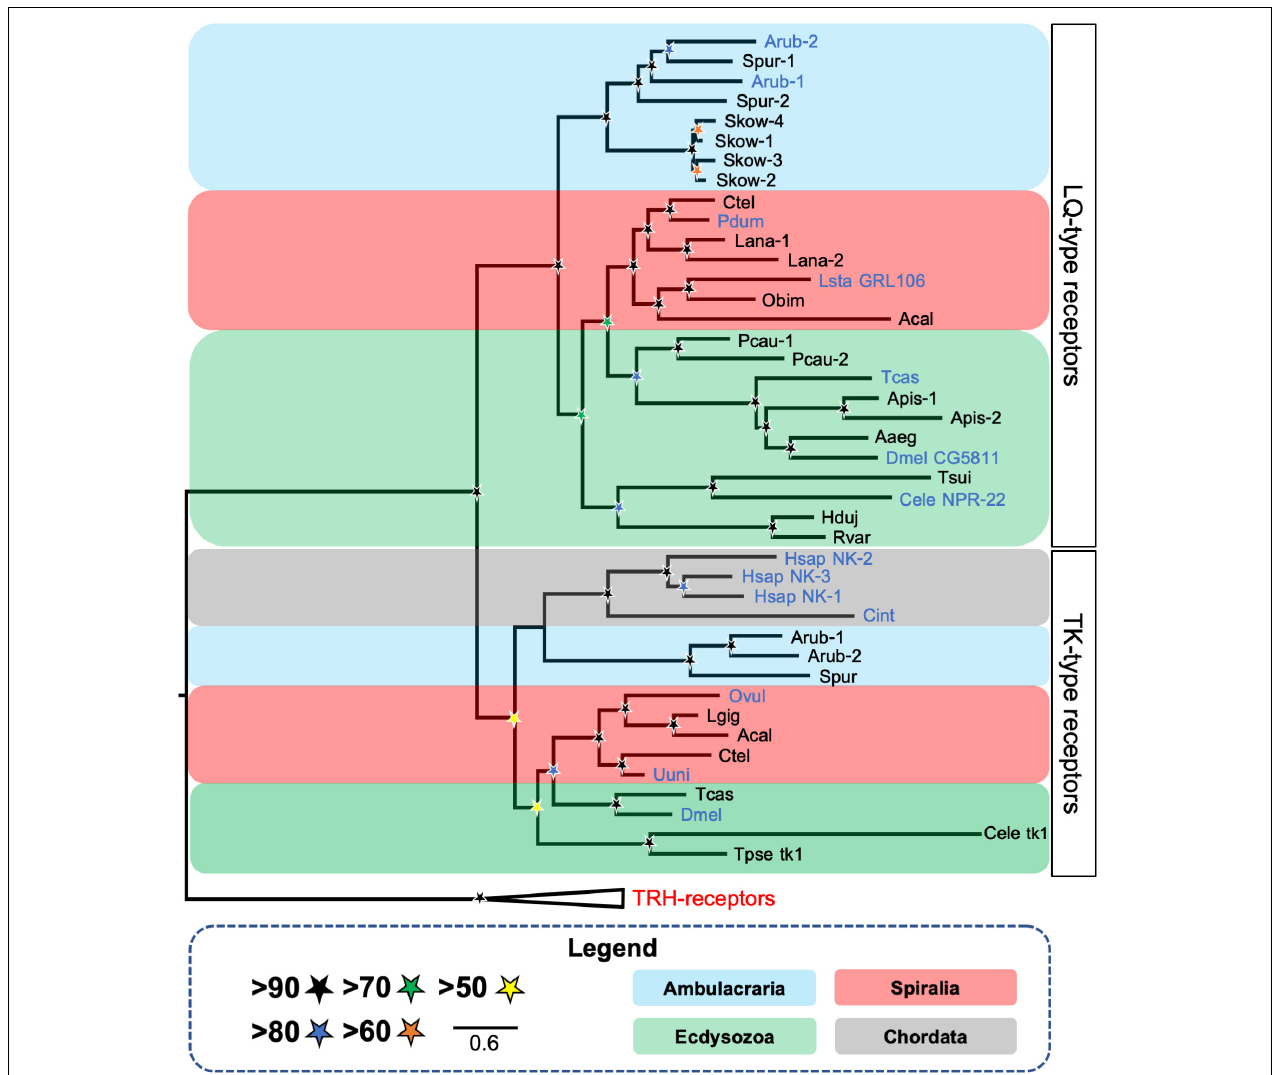
FIGURE 2 | Phylogenetic tree showing the occurrence and relationships of luqin/RYamide-type receptors and tachykinin-type receptors in bilaterians. The tree comprises two distinct receptor clades—luqin/RYamide-type receptors and the paralogous tachykinin-type receptors, with thyrotropin-releasing hormone (TRH)-type receptors included as an outgroup. Taxa are color-coded and SH-aLRT support (Guindon et al., 2010) [1000 replicates] for clades is represented with colored stars, as explained in the key. Species in which the peptide ligands that activate luqin/RYamide-type receptors or tachykinin-type receptors have been identified experimentally are shown with blue lettering. Species names are as follows: Aaeg ( Aedes aegypti ), Acal ( Aplysia californica ), Apis ( Acyrthosiphon pisum ), Arub ( Asterias rubens ), Cele ( Caenorhabditis elegans ), Cint ( Ciona intestinalis ), Ctel ( Capitella teleta ), Dmel ( Drosophila melanogaster ), Hduj ( Hypsibius dujardini ), Hsap ( Homo sapiens ), Lana ( Lingula anatina ), Lsta ( Lymnaea stagnalis ), Obim ( Octopus bimaculoides ), Ovul ( Octopus vulgaris ), Pcau ( Priapulus caudatus ), Pdum ( Platynereis dumerilii ), Rvar ( Ramazzottius varieornatus), Skow ( Saccoglossus kowalevskii ), Spur ( Strongylocentrotus purpuratus ), Tcas ( Tribolium castaneum ), Tsui ( Trichuris suis ), Tpse ( Trichinella pseudospiralis ), Uuni ( Urechis unicinctus ). This figure is a modified version of a tree reported previously in Yañez-Guerra et al. (2018), with the addition of published luqin-type receptor sequences from the tardigrades H. dujardini and R. varieornatus (Koziol, 2018) and the brachiopod L. anatina (XP_013402794.1, XP_013402807.1) and tachykinin-type receptor sequences from the nematodes C. elegans (tk-1; C38C10.1) (Mirabeau and Joly, 2013) and T. spiralis (KRY8989.1). The alignment was performed using MUSCLE (Edgar, 2004) [16 iterations] and the trimming was made using BMGE (Criscuolo and